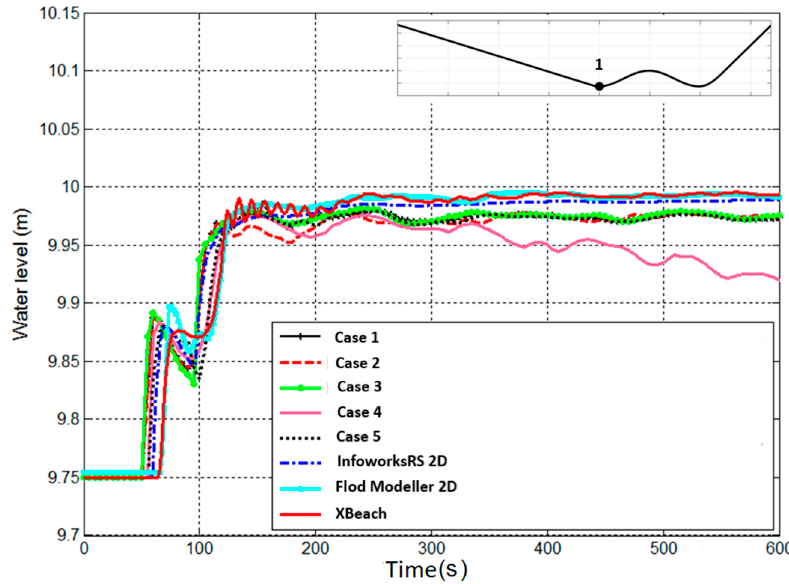
Figure 14. Momentum conservation over a bump: Point 1 water level results.